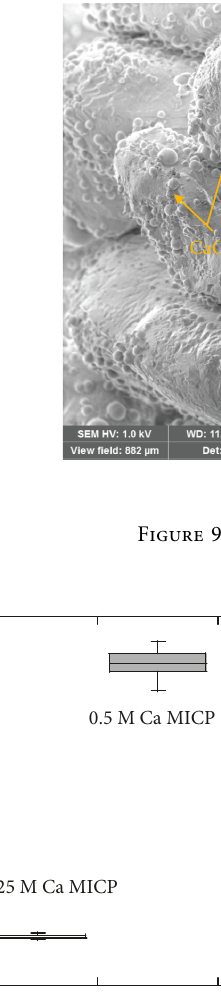
Figure 10: Unconfined compressive strength of MICP-treated and cement-treated samples.